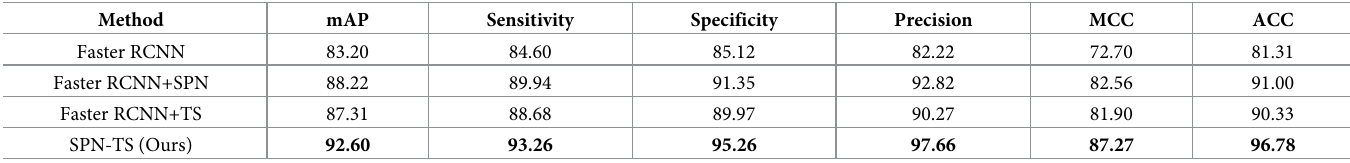
Table 3. The detection effects of the two modules based on baselines Faster RCNN. Method mAP Sensitivity Specificity Precision MCC ACC Faster RCNN